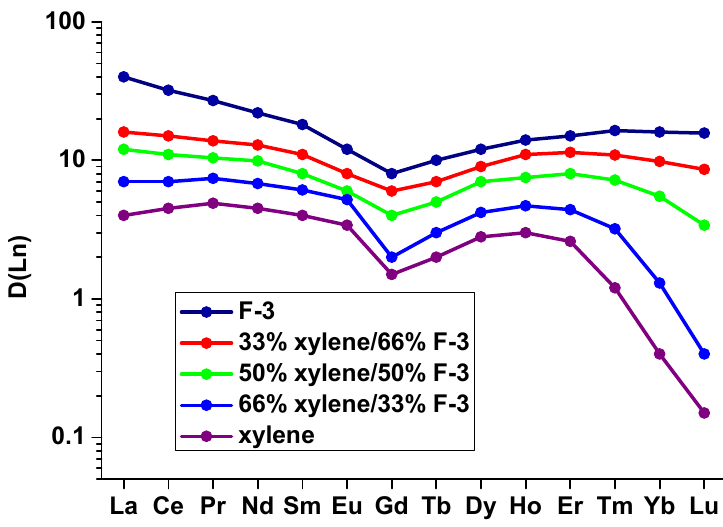
Figure 8. Distribution ratios D of Ln cations during their extraction from 3 M HNO 3 with ligand L2 (0.7 mol/L) in pure F-3 and its mixtures with para-xylene.